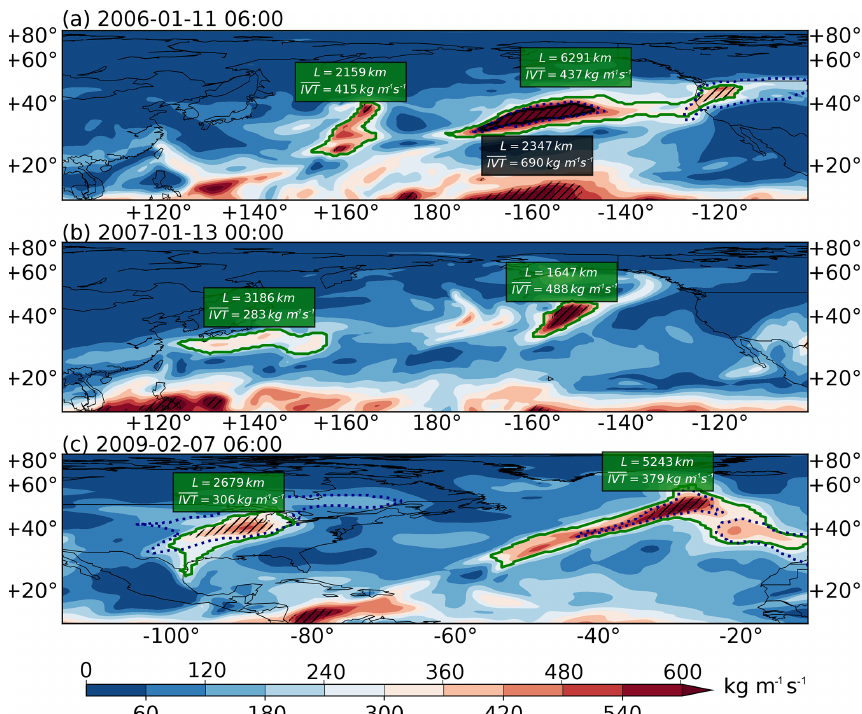
Figure 5. Snapshots of IVT distributions on (a) 11 January 2006 at 06:00UTC over the North Pacific, (b) 13 January 2007 at 00:00UTC over the North Pacific and (c) 7 February 2009 at 06:00UTC over the North Atlantic. ARs found by the THR-t4-s6 method are drawn in solid green contours, those by the IVT250ano method in solid black contours and those by IVT85% in dotted black contours. Length (in km) and area-averaged IVT (in kgm − 1 s − 1 ) for the THR-t4-s6 (IVT250ano) ARs are labeled out in green (black) boxes. Hatching indicates areas where the IVT anomalies are above the 250kgm − 1 s − 1